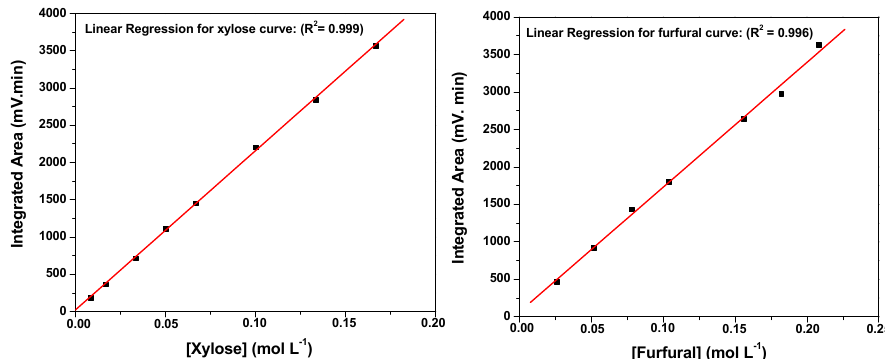
Figure 1. Analytical curves of xylose and furfural obtained by high performance liquid chromatography (HPLC)-refractive index (RID).